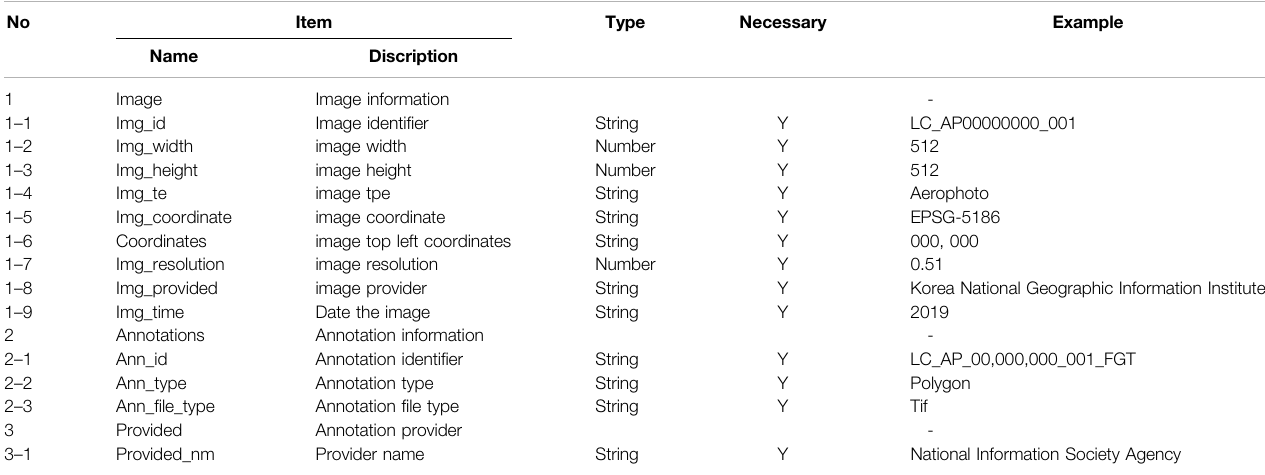
TABLE 3 | Information contained in metadata in json